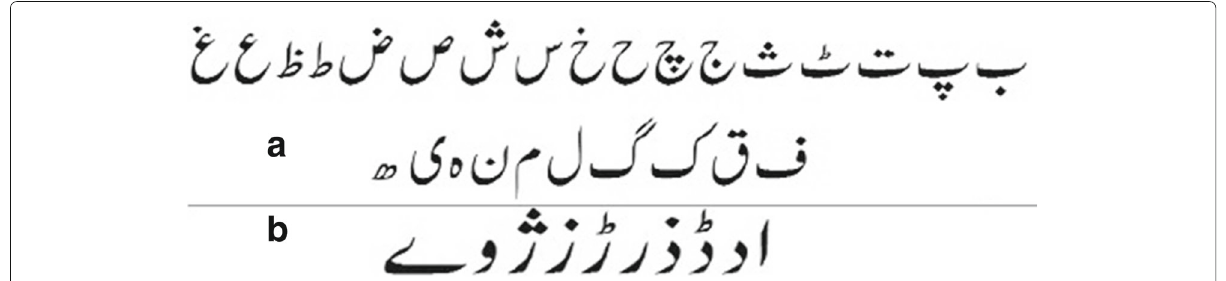
Fig. 2 Urdu character set with a joiners and b non-joiner separated